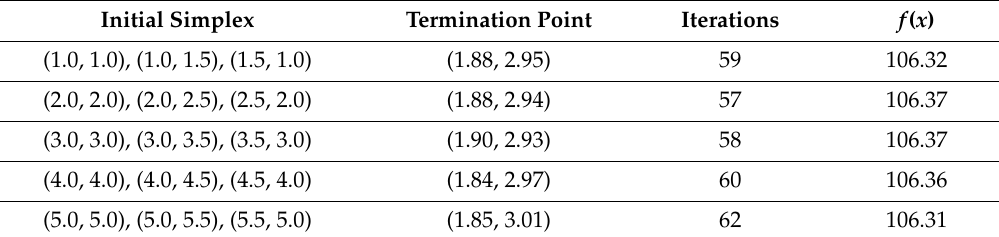
Table 4. Optimization Results Considering Unbalanced Voltage Distribution ( ± 10% Q rr Distribution). Initial